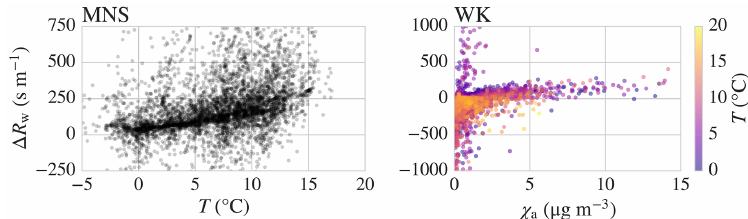
Figure 5. Differences between modeled and measured 30min nighttime non-stomatal resistances ( (cid:49)R w ) as a function of T and/or χ a . (Left panel) Increasing mismatch of measured and modeled R w in the MNS model due to a too strong T response. The line-shaped pattern emerges from times when observed R w is zero and is equal in magnitude to the minimum allowed R w in the parameterization. (Right panel) The WK model reveals a tendency for both stronger over- and underestimation of observed R w with increasing χ a , where overestimation occurs more frequently during colder conditions and underestimation during warmer